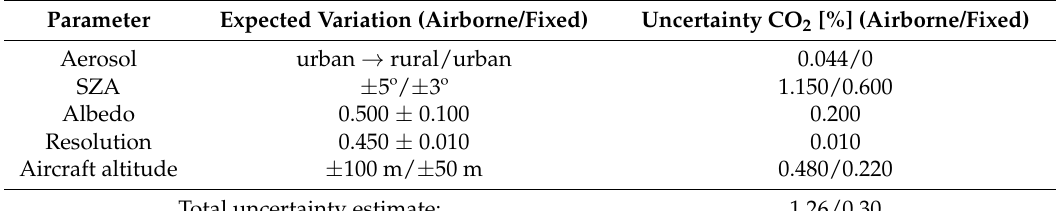
Table 6. Total uncertainties to be estimated in a WFM-DOAS retrieval of CO 2 total column.